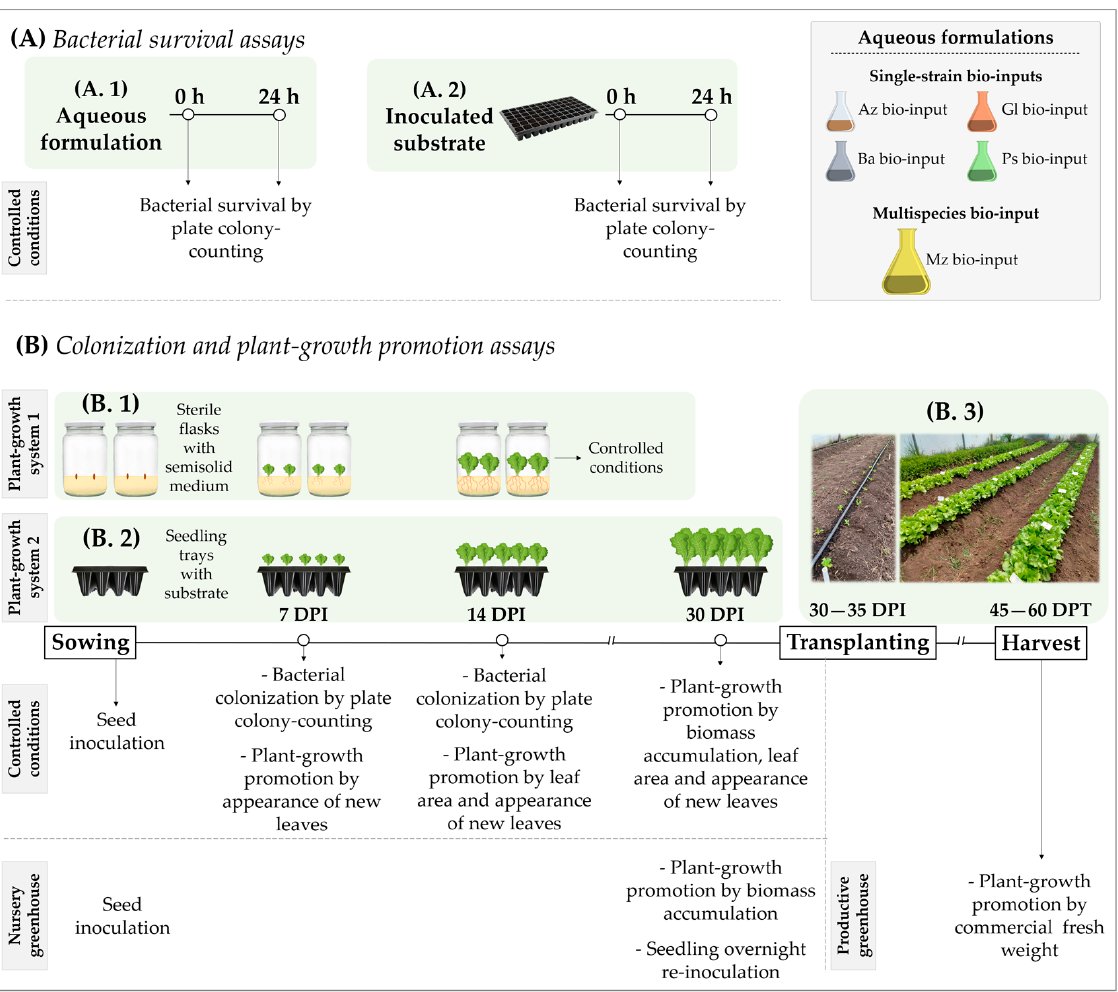
Figure 1. Graphical abstract of tracking and plant-growth–promotion assays of bacterial strains. Seedling time is expressed in days post-inoculation (DPI) and days post-transplanting (DPT).